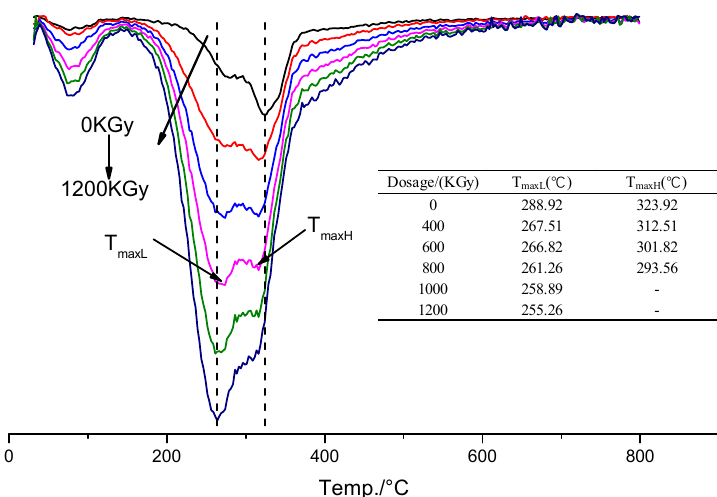
Figure 2. Effect of absorbed doses on the thermal stability profiles of Miscanthus biomass.